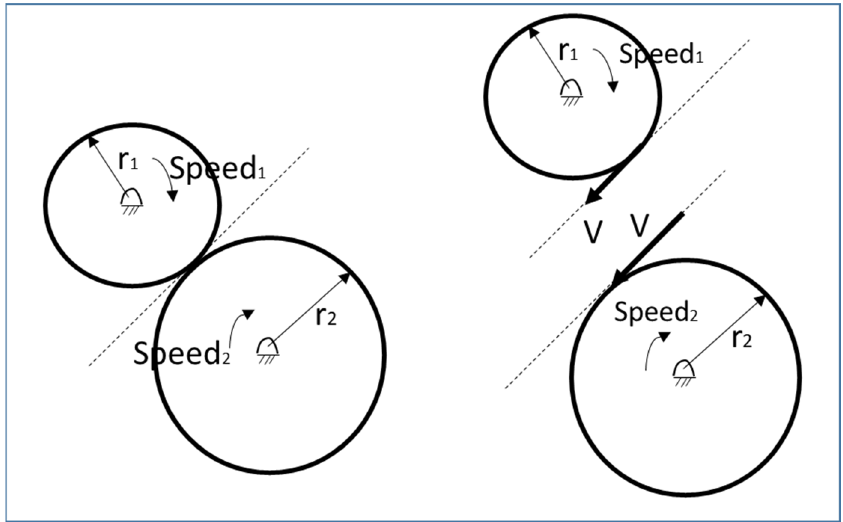
Figure 4. Flywheel and motor speed relationship (free body diagram).